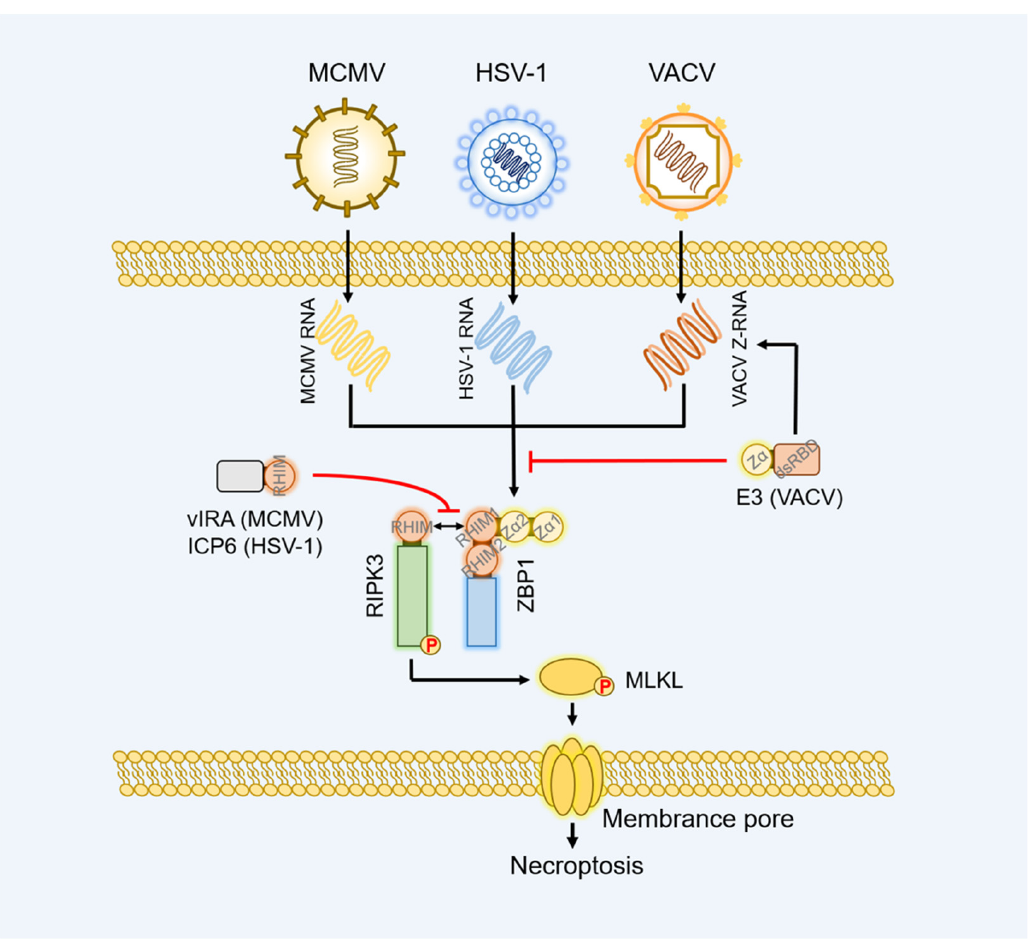
Figure 3. DNA viruses developed antagonistic mechanisms against ZBP1 signaling. After sensing virus-derived RNA, ZBP1 triggers necroptosis via the ZBP1-RIPK3-MLKL axis against MCMV, HSV-1, or VACV infection. However, the ZBP1 signaling is blocked by the DNA viruses-encoded virulence factors. At the beginning of the necroptosis signaling, the VACV E3 protein shields the VACV Z-RNA by its Z α domain and abolishes the activation of ZBP1. After that, the homologous RHIM of MCMV vIRA and HSV-1 ICP6 destroys the signaling transduction from ZBP1 to RIPK3.